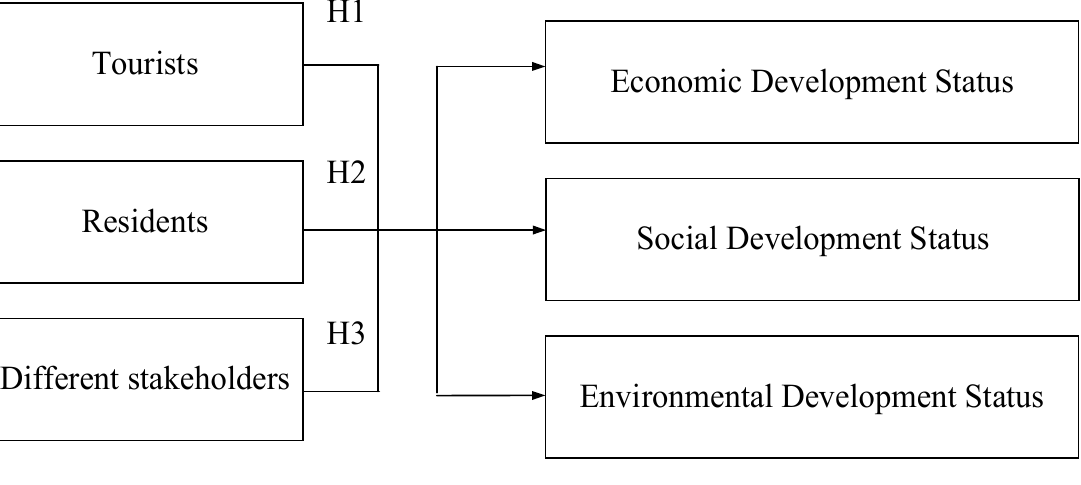
Figure 2. Study Figure 2. Study framework.